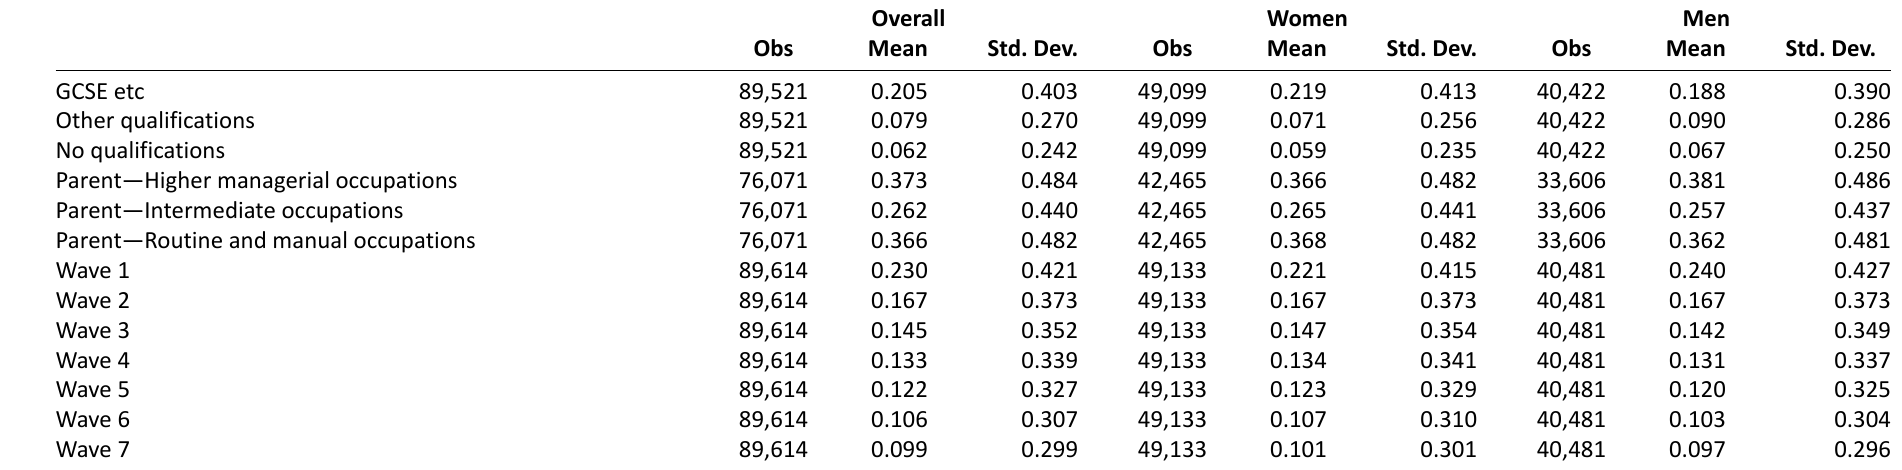
Table A2. (Cont.) UKHLS waves 1–7 summary